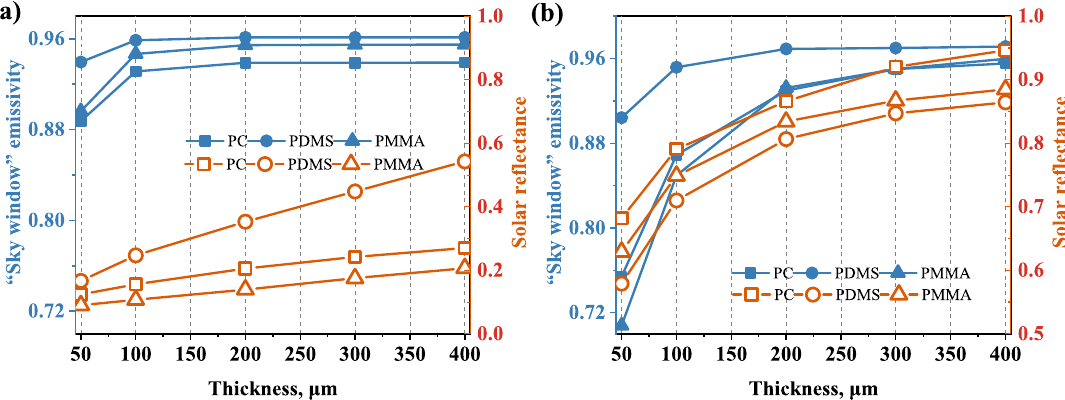
Figure 4. Effect of thickness on the radiative properties of different structures. ( a ) RDSP structure and ( b ) porous